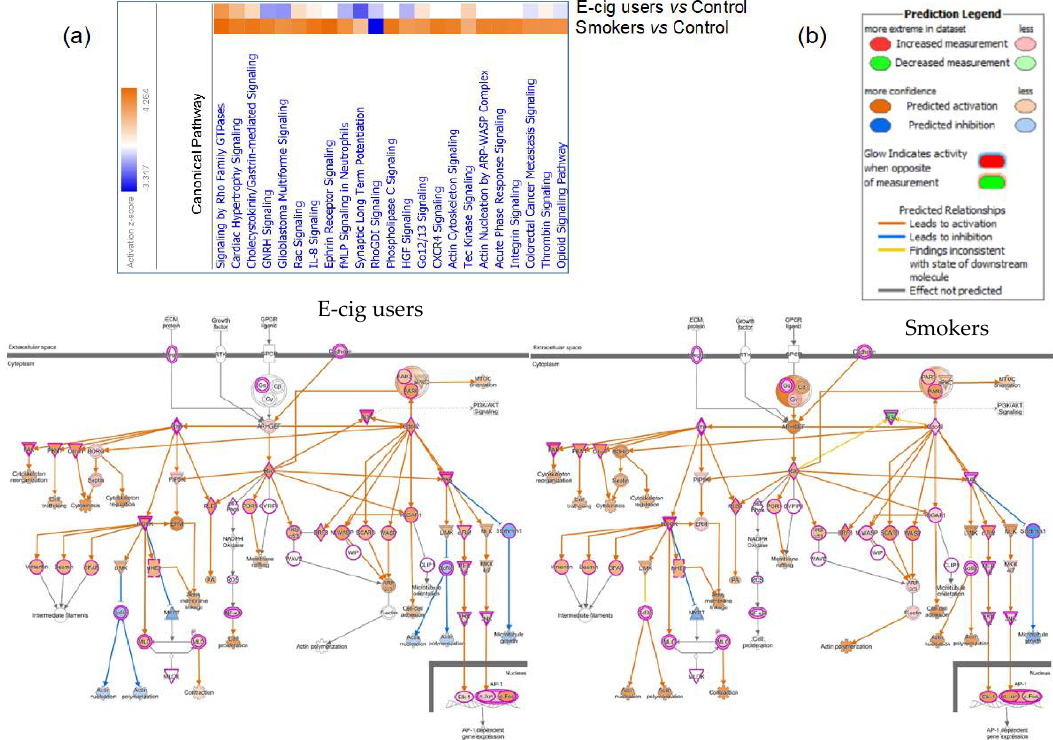
Figure 4. Common canonical pathways disrupted in e-cig users and smokers relative to controls by IPA ® . ( a ) The canonical pathway heatmap visualizes the affected canonical pathways simultaneously in e-cig users and smokers, allowing a direct comparison between the two groups. ( b ) Predicting how up-regulated and down-regulated genes in the datasets (red and green nodes, respectively, on the pathway) can affect the activity of other molecules on the pathway. Orange nodes, prediction of activation; blue nodes, prediction of inhibition.